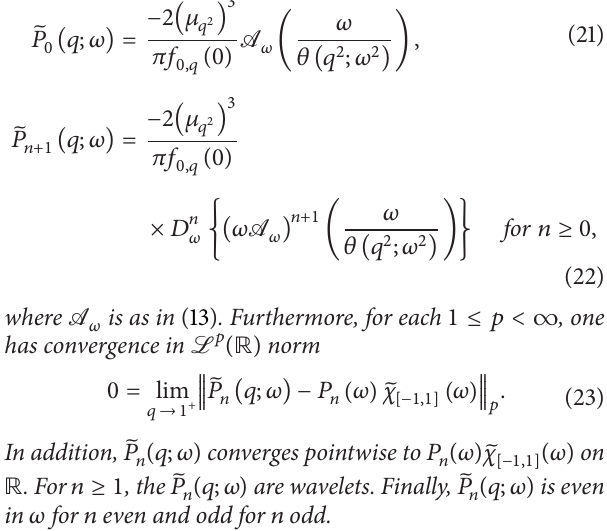
(𝜔)̃𝜒 (𝜔) which is dashed. (b) ̃𝑃 0 [−1,1] (𝑞;𝜔) is shown in solid for 𝑞 = 1.20 and is compared with 𝑃 2